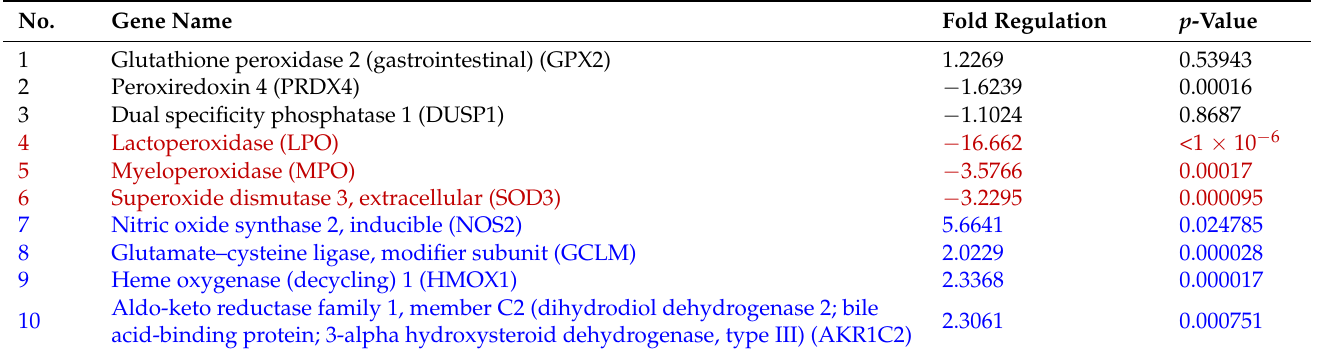
Figure 4. Verifying the expression level of the representative changed genes using RT-PCR analysis. The total RNA was extracted from human control nasal mucosae and CRSwNP NP tissues. ( A ) The representative downregulated GPX3, SOD3, and MPO and ( B ) the upregulated NCOA7, NOS2 (iNOS), and HMOX-1 (HO-1) mRNA expression levels were determined using RT-PCR to verify their changes in a real-time PCR array assay. Data are mean ± SEM. C: control; W: CRSwNP. ** p < 0.01 and *** p < 0.001 versus control. Table 3. Confirmation of the selected gene expressions in Table 2 via a customized microarray analysis of 18 additional NPs from the CRSwNP patients; up- and downregulated genes with p -values < 0.05 are highlighted in blue and red,